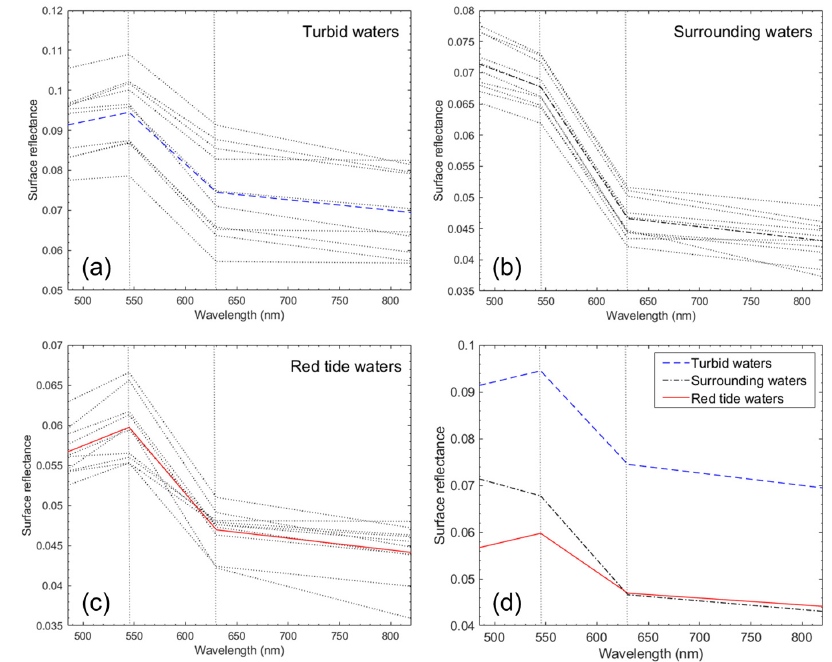
Figure 5. Spectra of ( a ) turbid waters, ( b ) the surrounding water, ( c ) red tide waters, and ( d ) the average spectra of three water types in the coast of Goheung from 3B SR PlanetScope image on 29 July 2018 at 01:42 GMT. For spectra extraction of the three water types, pixels were randomly selected from the regions in Figure 3a–c. Blue dashed, black dash-dot, and red lines indicate the average over the extracted spectra in ( a – c ), respectively.